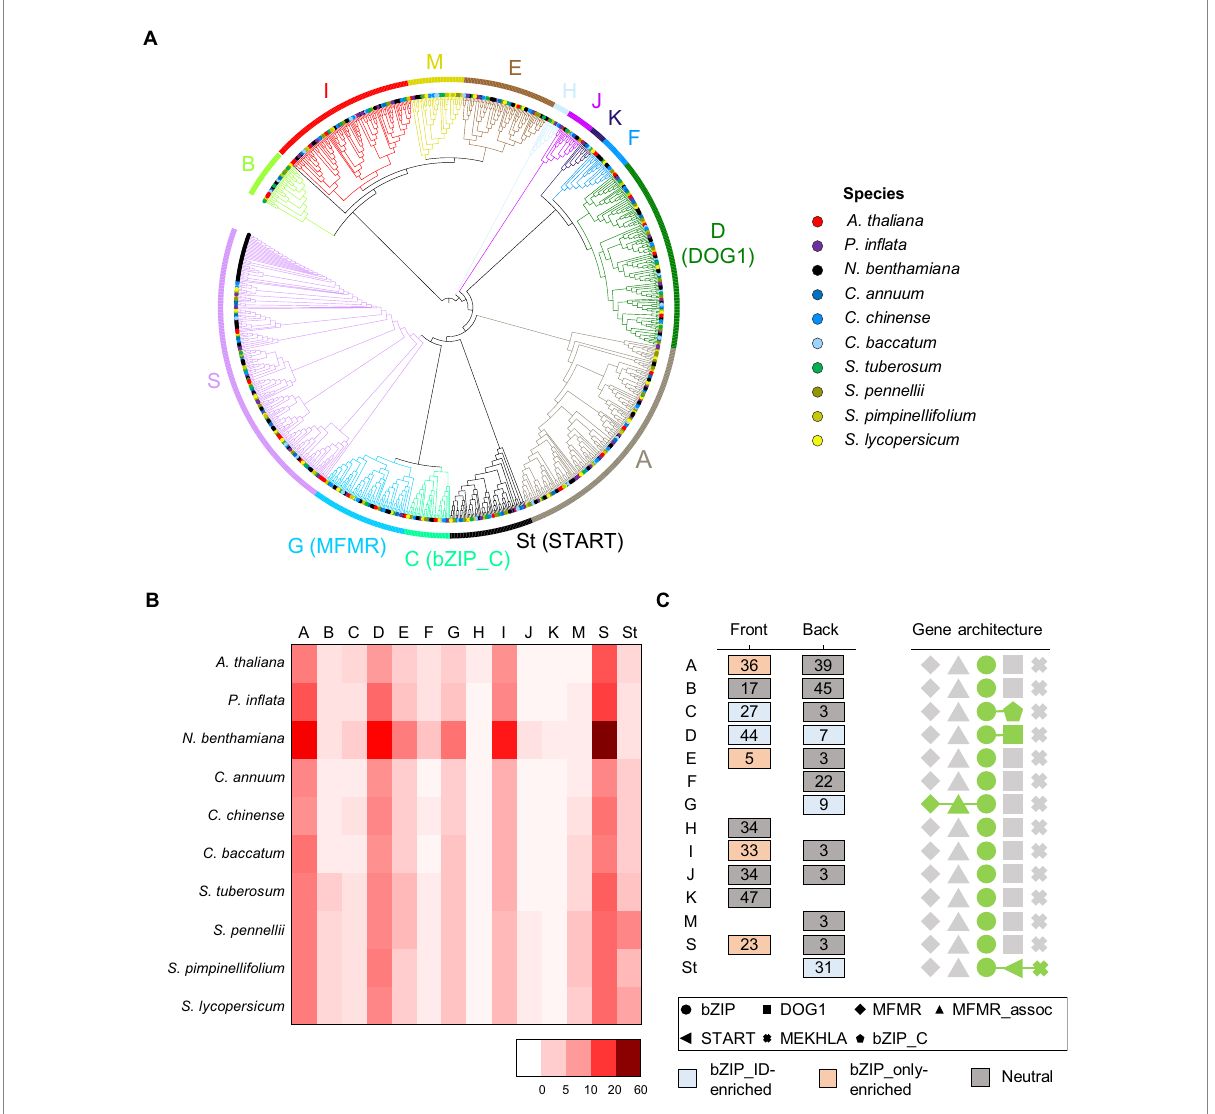
FIGURE 3 Phylogenetic relationships among bZIP genes and subgroup characteristics. (A) Phylogenetic tree of bZIP genes in the 10 plant species. Different species on the end of the branch are denoted by different colors. The colored branch and colored bars on the outer ring represent individual subgroups. Subgroup names are listed next to the outer rings representing integrated domains in the bracket. (B) The numbers of bZIP genes in subgroups by species are shown in a heatmap. Scale bars on the bottom right side indicate the number of genes. (C) The most abundant motifs adjacent to the bZIP domain are portrayed. Numbers in boxes indicate motif labels. The box colors represent the type of enriched motifs. The top five domain architecture repertoires are shown on the right side as different geometric